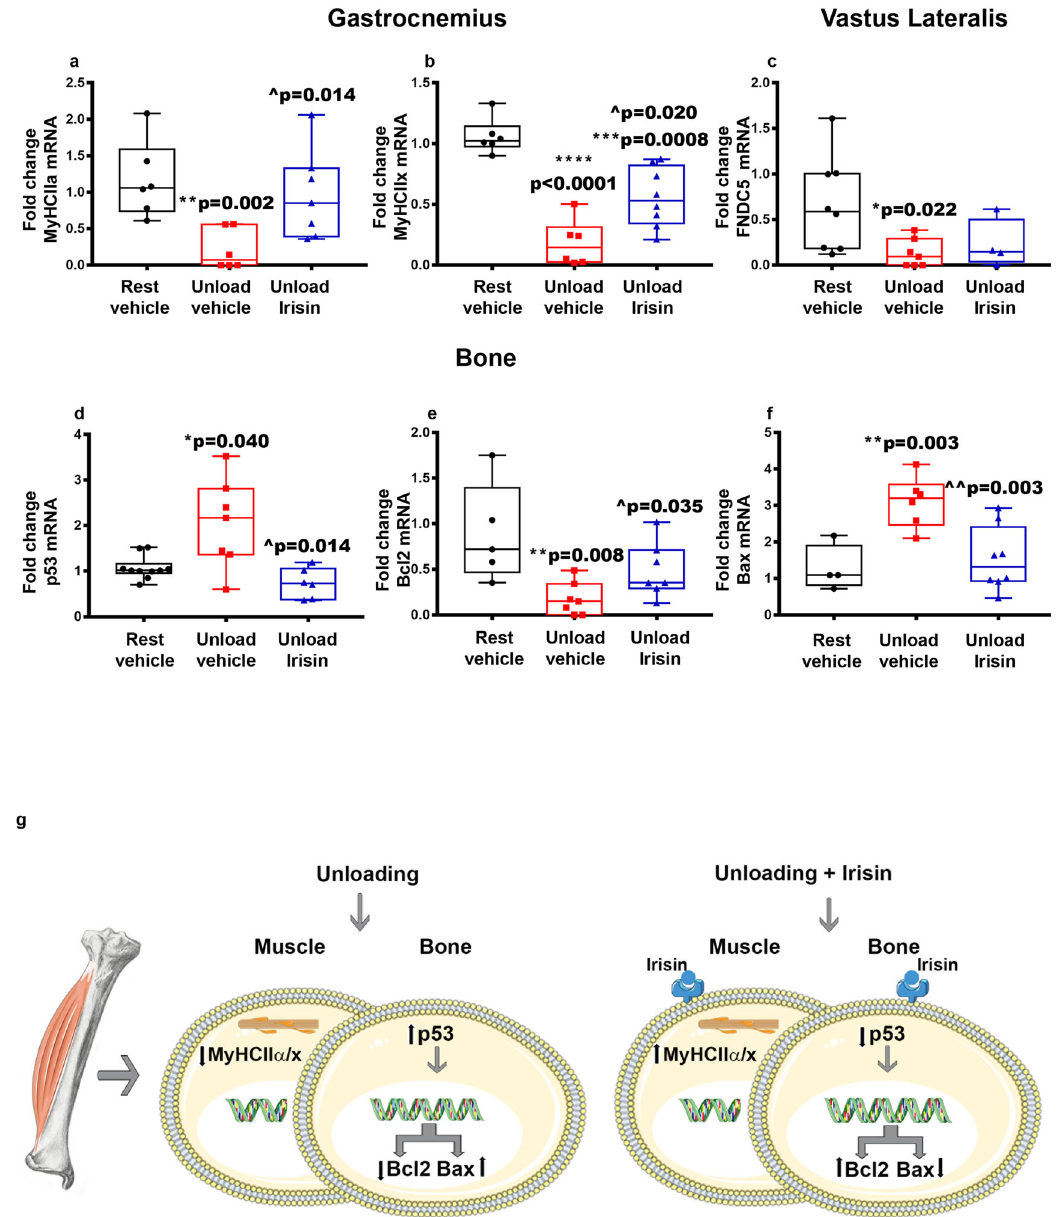
Fig. 9 Effect of irisin on the musculoskeletal system of hind-limb suspended mice. Quantitative PCR (qPCR) showing mRNA expression levels of MyHCII α , MyHCIIx in Gastrocnemius muscle ( a , b ), FNDC5 in Vastus Lateralis muscle ( c ) and p53 , Bcl2 and Bax ( d – f ) in cortical bone of control mice kept in rest condition (Rest) and HU mice (Unload) treated with vehicle or irisin (100 μ g/kg) once a week for 4 weeks. Data showed a signi fi cant reduction of MyHCII α and MyHCIIx expression in unload mice treated with vehicle compared to controls (Rest), whereas irisin treatment restored MyHCII α expression to control values ( a ). Albeit not returned to control levels, irisin treatment signi fi cantly increased the expression of MyHCIIx myosin compared to unload mice treated with vehicle ( b ). In Vastus Lateralis, irisin treatment was not effective in preventing FNDC5 decline ( c ). The signi fi cant increase in p53 expression in unload mice treated with vehicle was prevented by irisin treatment in unload mice ( d ). The unloaded-induced modulation of Bcl2 and Bax were restored to control levels by irisin treatment in unload mice ( e , f ). Scheme summarizing the effects of unloading and irisin treatment on the expression of myosins in muscle and p53 , Bcl2 and Bax in cortical bone ( g ). Shapiro-Wilk test and Mann-Whitney test were performed. Data are presented as box-and-whisker with median and interquartile ranges, from max to min, with all data points shown. * p < 0.05, ** p < 0.01, **** p < 0.0001 vs Rest and ^ p < 0.05, ^^ p < 0.001 vs Unload Histological analysis of bone Histological analysis of muscle Freshly dissected femurs were immediately fi xed in ice-cold 4% Vastus lateralis muscles were excised from the quadriceps, fi xed, paraformaldehyde solution for 4 h. After decalci fi cation, per- and embedded in paraf fi n. 5 µm thick histological sections were formed with 0.5 M ethylenediaminetetraacetic acid (EDTA) at cut and stained with hematoxylin and eosin (H&E). All observa- 4 °C, bones were immersed into 20% sucrose and 2% polyvinyl- tions were performed with a Nikon Eclipse 80i light microscope pyrrolidone (PVP) solution for 24 h. Femurs were then embedded (Nikon) at magni fi cation of 20x by using the NIS-Element BR and frozen in optimal cutting temperature (OCT) compound 4.10.00 software.